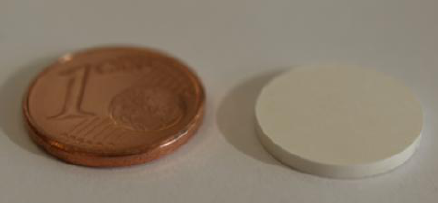
Figure 1. Pressed pellets of the solid polyelectrolyte complexes (PEC) materials before sputtering.